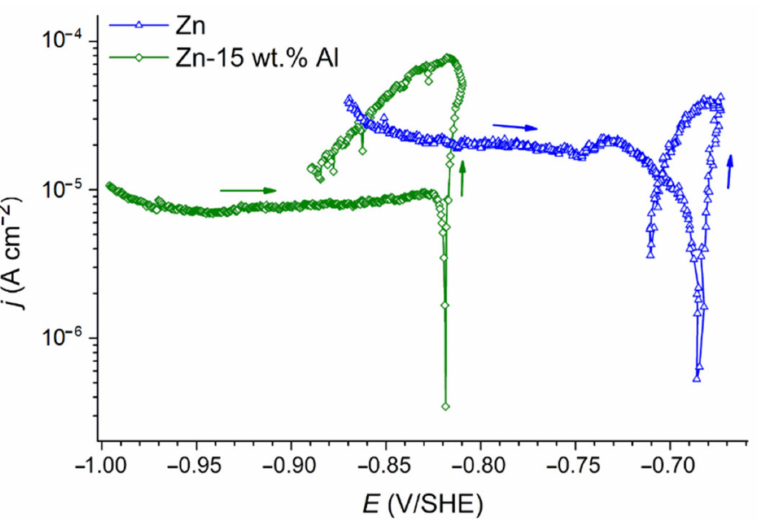
Figure 4. Polarization curves obtained with Zn- and Zn-15wt.%Al-coated carbon steel electrodes after 1.5 h of immersion in “solution 15” at 80 ◦